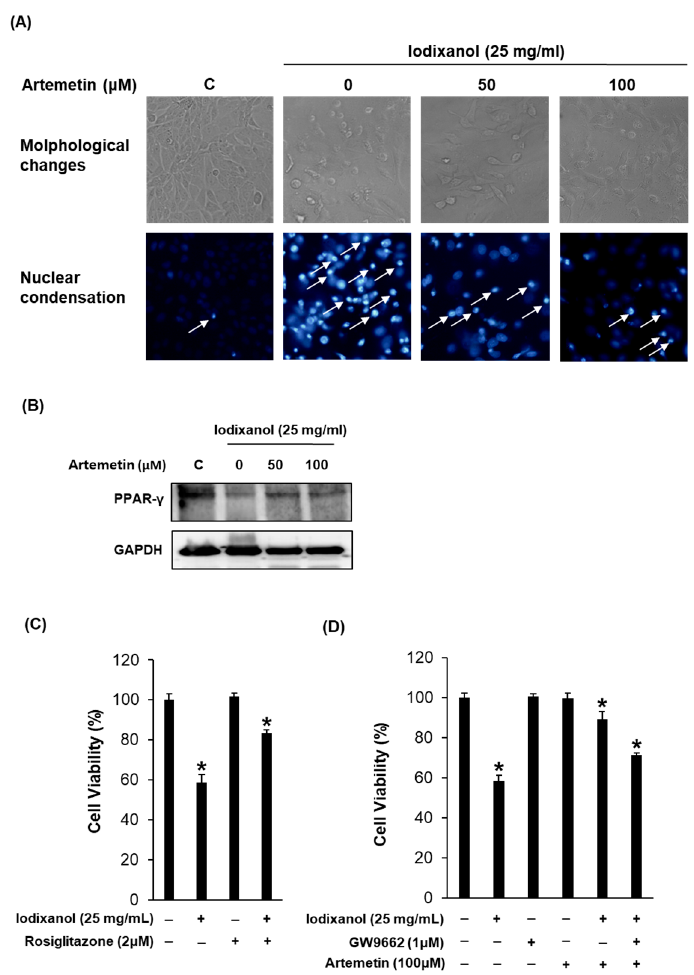
Figure 6. Effects of artemetin on the morphological changes, degree of nuclear condensation and protein expression of PPAR- γ in the iodixanol-induced nephrotoxicity of LLC-PK1 cells treated with vehicle control (0.5% DMSO), iodixanol (25 mg/mL), and artemetin (50 and 100 μ M) for 3 h: ( A ) morphological changes and degree of nuclear condensation as determined by measuring the level of Hoechst 33342 fluorescence; ( B ) protein expression of PPAR- γ ; ( C ) effect of PPAR- γ ligand (rosiglitazone) on iodixanol-induced cytotoxicity in LLC-PK1 cells; and ( D ) effect of PPAR- γ antagonist (GW9662) on iodixanol-induced cytotoxicity in LLC-PK1 cells. * p < 0.05 compared to the not-treated